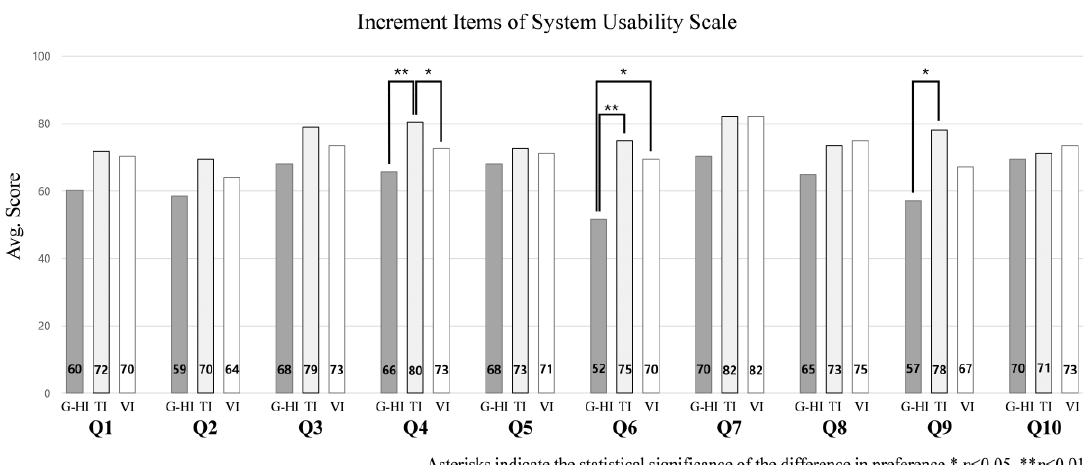
Figure 8. Ten increment items of system usability scale scores for the three input interactions.